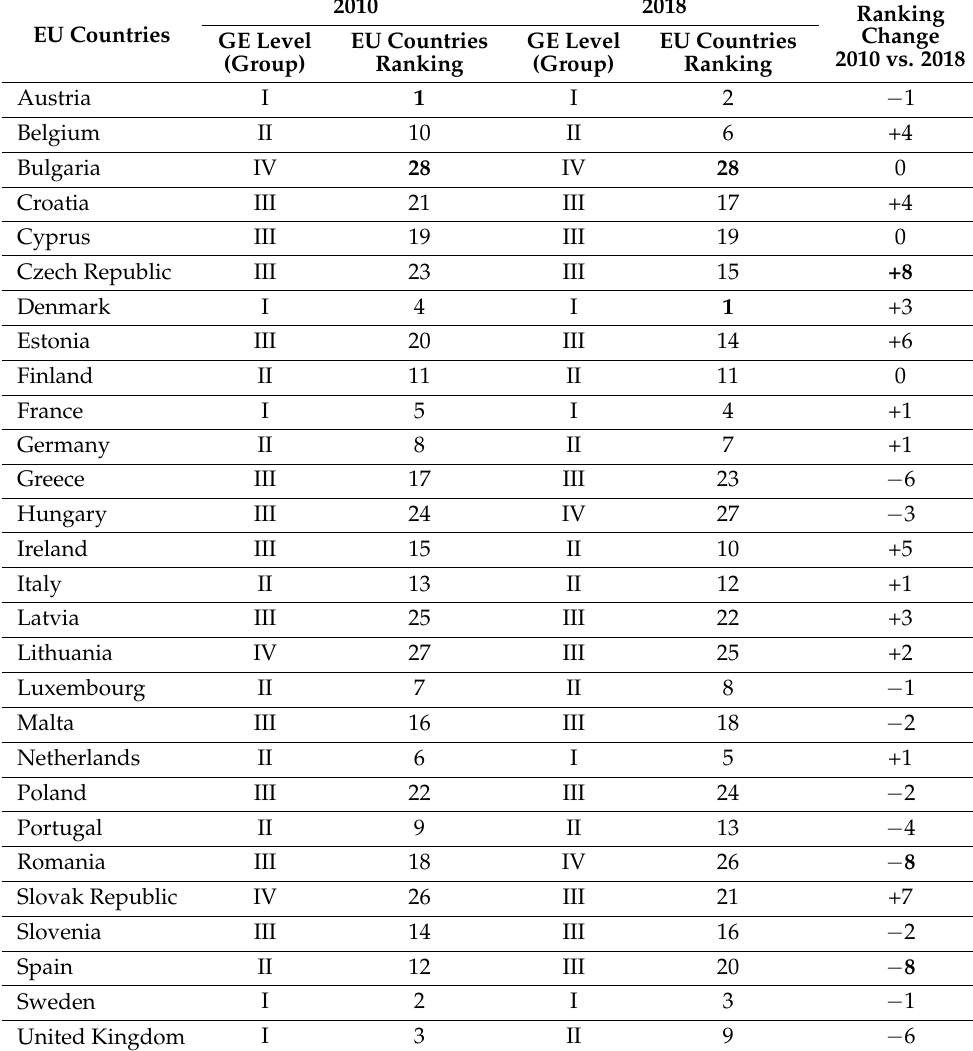
Table 2. Green economy in EU countries in 2010 and 2018. EU